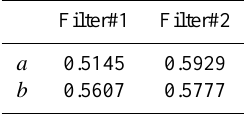
Table 1. Coefficients a and b obtained for Filter#1 centered